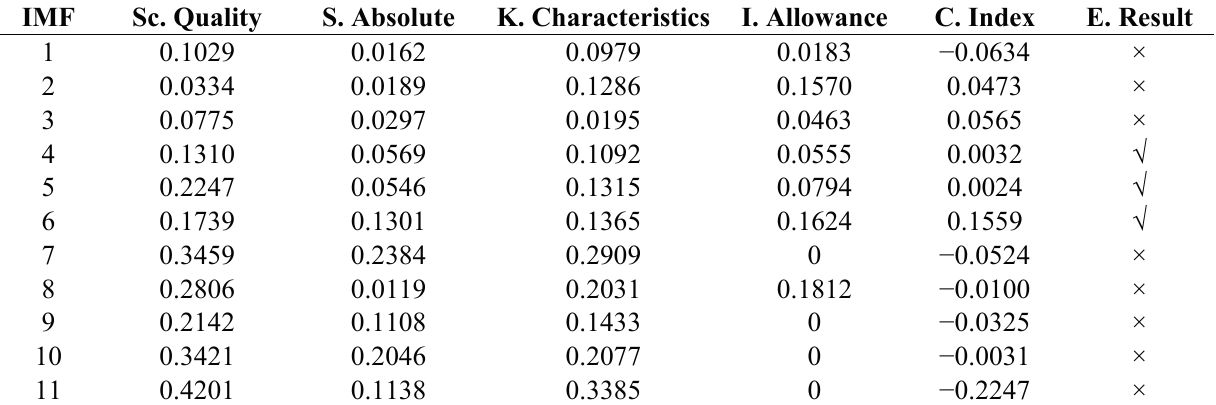
Table 3. IMFs’ confidence index calculation for the axle bearing vibration with outer ring fault. IMF Sc.